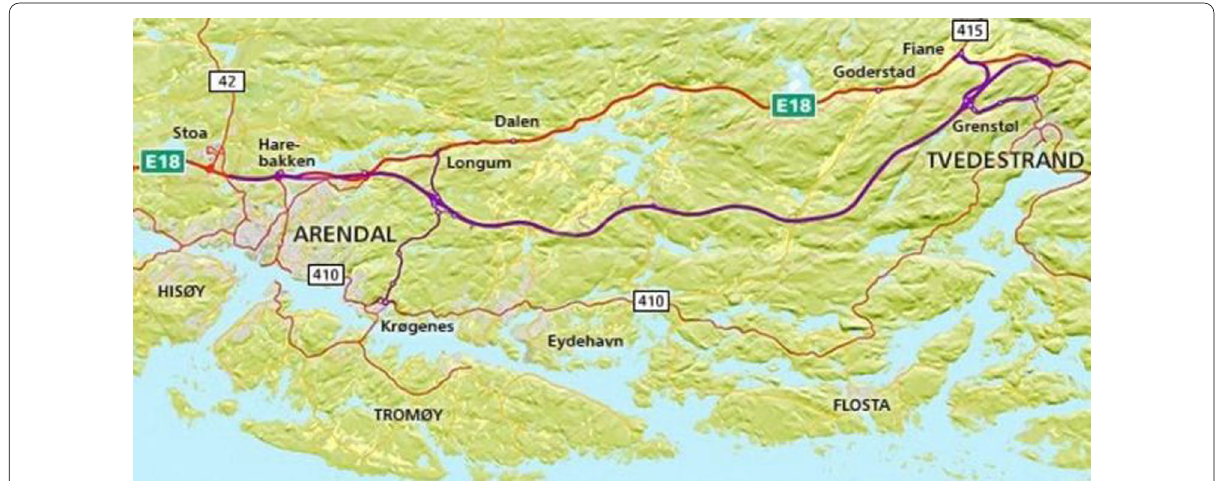
Fig. 2 New motorway (in purple) and old motorway (in red) between Tvedestrand and Arendal (case 1) in the south of